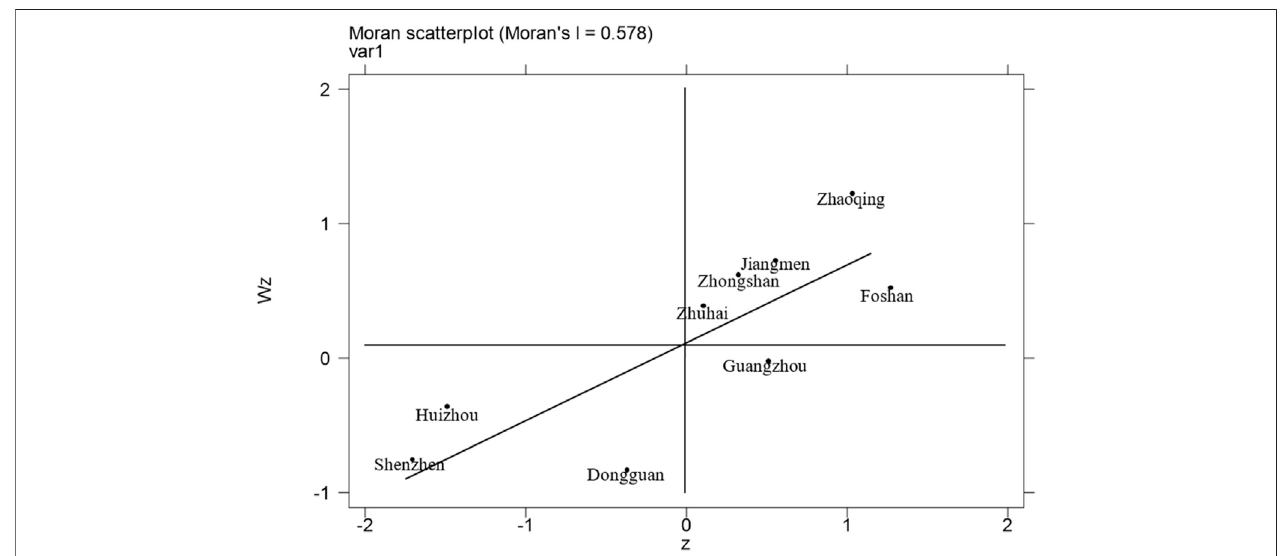
FIGURE 5 | Moran scatter plot of PM 2.5 in the Pearl River Delta region in 2000.